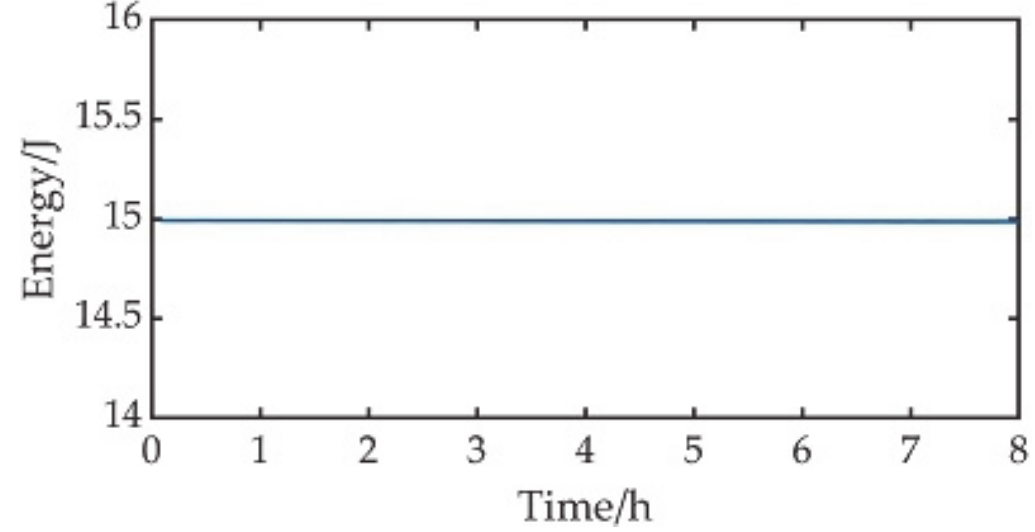
Figure 6. Simulation results of the total energy received by the PD in a single gaze time versus time in Experiment 1.